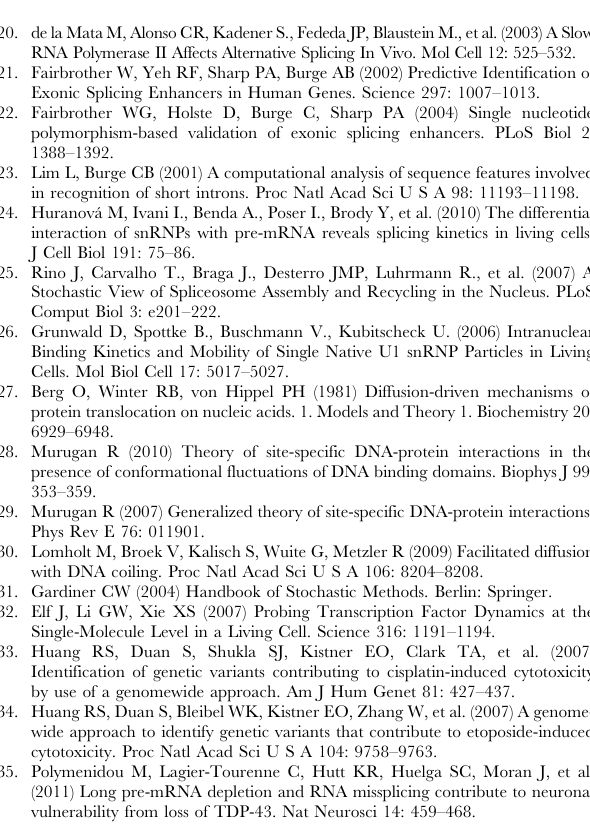
Figure S3 This figure provides complementary data to Figure 4. A–B. Standard error of the FENAS signal for mouse ( A ) and human ( B ). There is one line for each tissue but the curves overlap. C–D . Number of transcripts (count) with a given exon number for mouse ( C ) and human ( D ). (PDF) Figure S4 This figure provides complementary data to Figure 6. A–B. Standard error of h m,k for mouse ( A ) and human ( B ). C–D . Number of transcripts (count) with a given number of exons in mouse ( C ) and human ( D ). (PDF) Text S1 List of variables defined in the